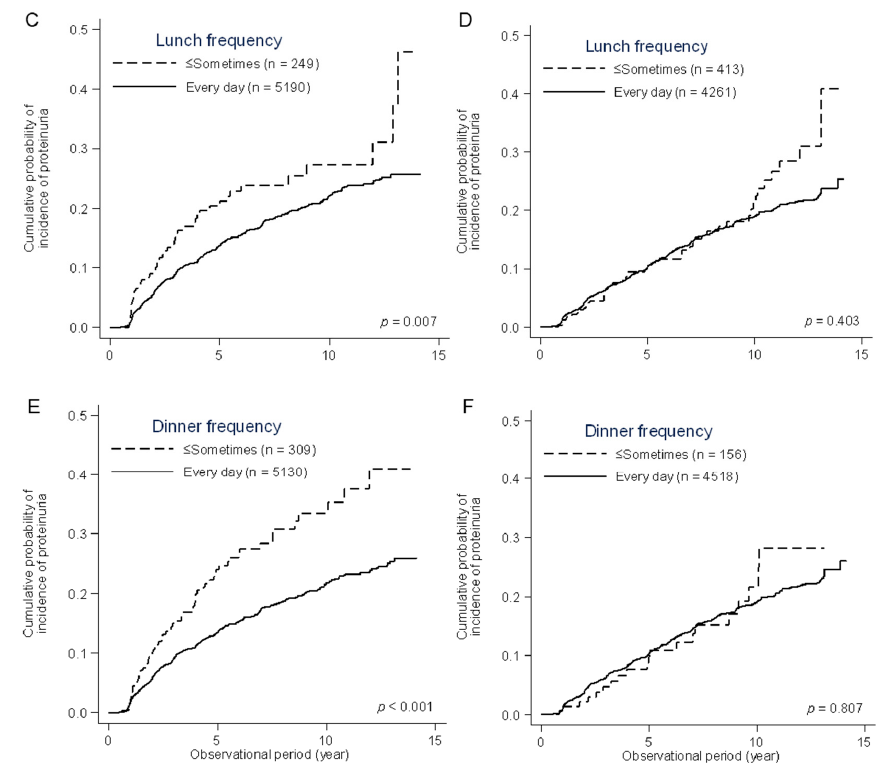
Figure 2. Cumulative probability of the incidence of proteinuria in females and males, stratified by the frequency of breakfast, lunch, and dinner. A significant difference was observed in the frequency of breakfast ( A ), lunch ( C ), and dinner ( E ) in females, not in males ( B , D , F ).